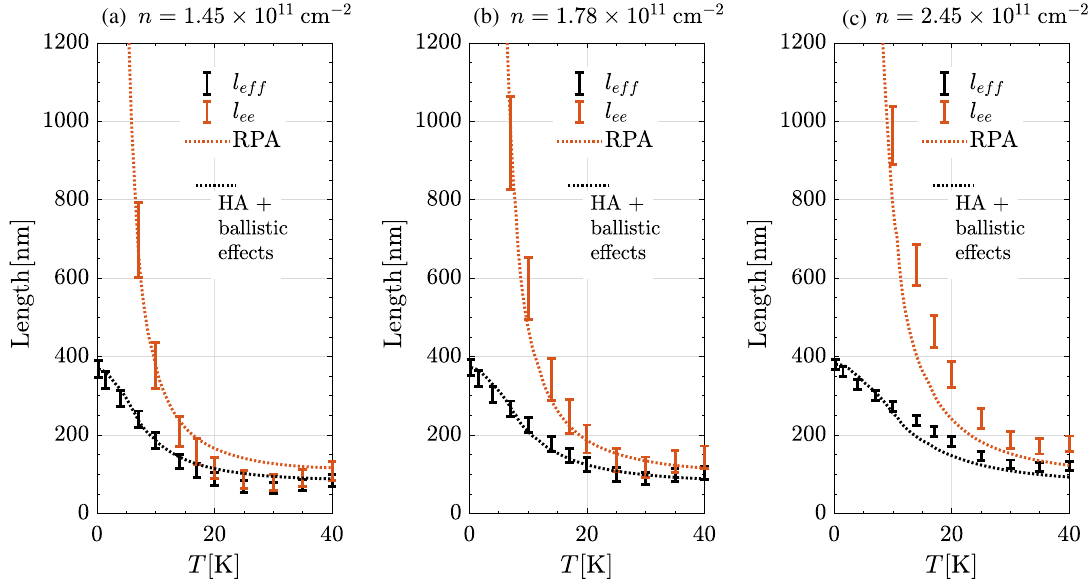
¼ 4 ν =v FIG. 5. Extracted l and the viscous effective length l as a function of the temperature for three different number densities: ee F eff ¼ v = ð 4 ν Þ extracted and the viscous effective length l (a) 1.45, (b) 1.78, and (c) 2.45 in units of 10 11 cm − 2 . The error bars are the l ee F eff from resistance data by solving Navier-Stokes equation (E1) and using the formula in Eq. (G1) that captures size effects. The uncertainty is due to the possible variation of impurity concentration as discussed in Appendixes A and D. Dotted orange lines are the theoretical calculation of the l using RPA and Boltzmann theory, with no free parameters, as outlined in Appendix F. The dotted black line shows ee the viscous effective length we calculate by using theoretical l and Eq. ee